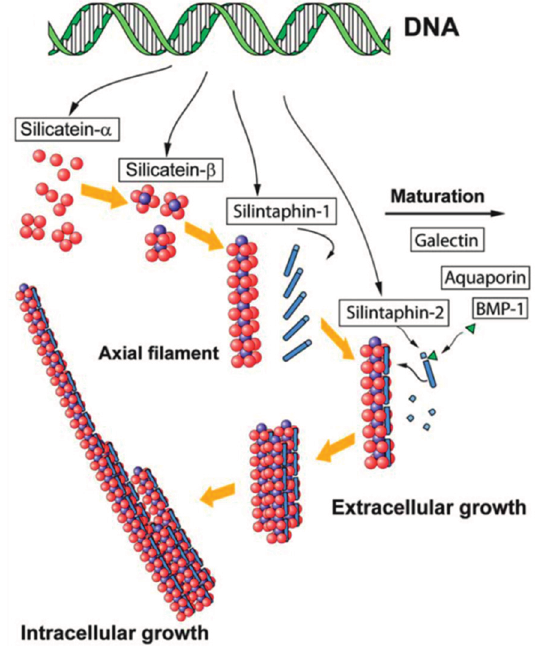
Figure 2. The self-assembly process of the organic layers in siliceous spicules. Copyright 2012 The Royal Society of Chemistry. Reprinted with permission from reference